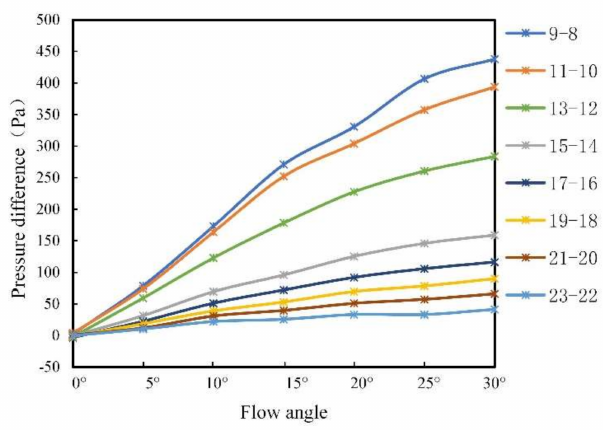
Figure 21. Pressure di ff erence curves after truncation.